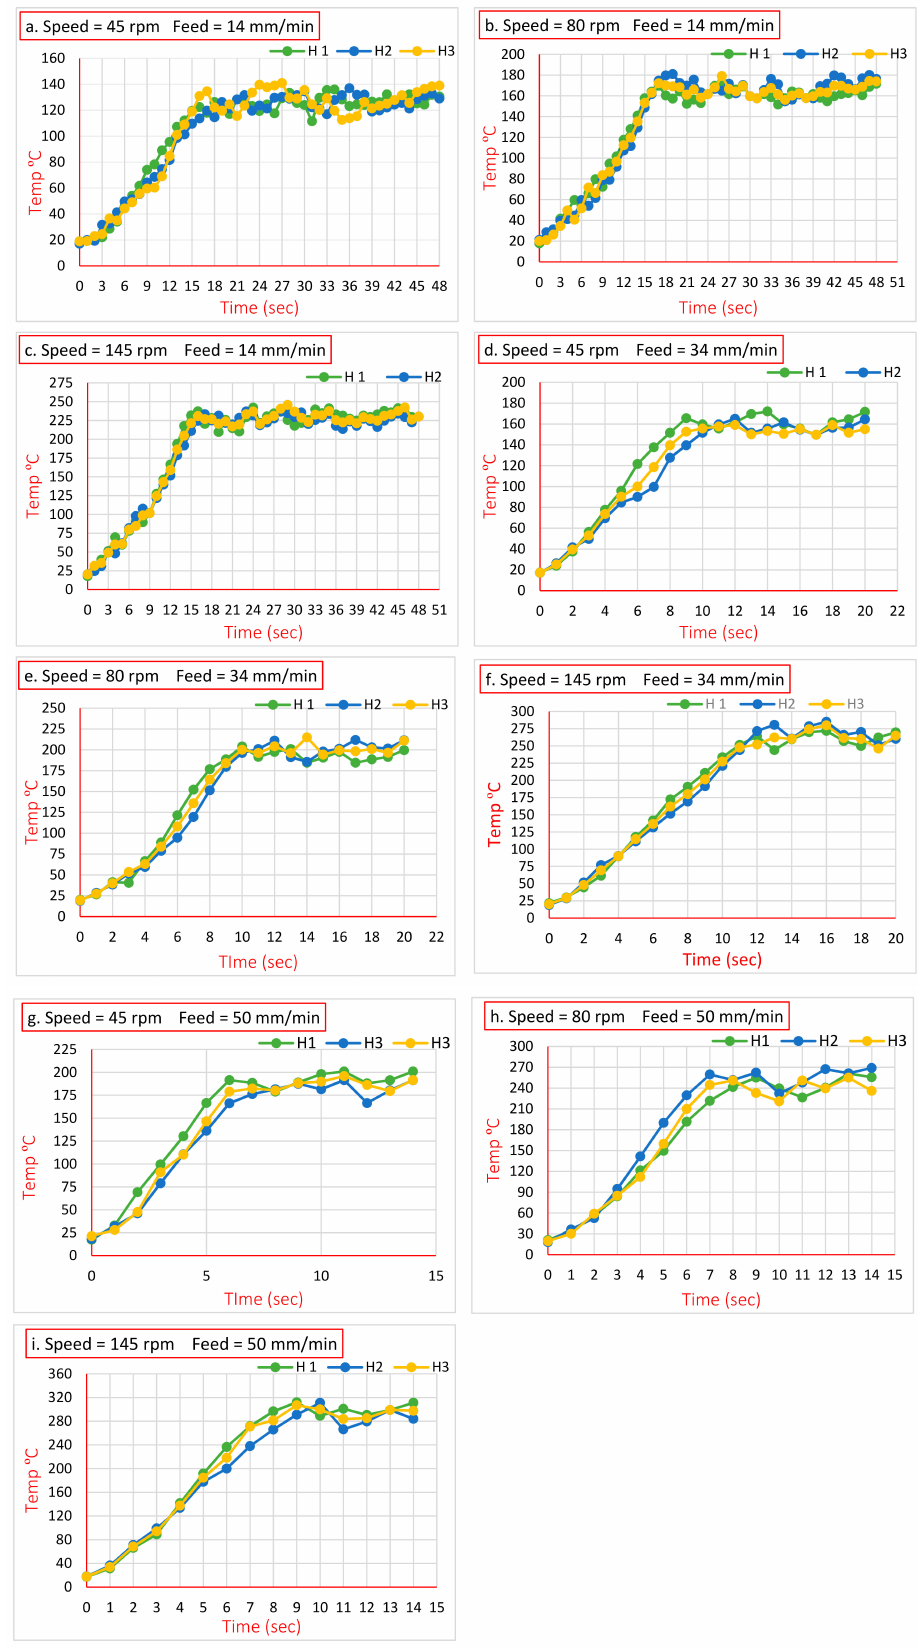
Figure 9. Temperature changing profiles during drilling for each set of cutting conditions ( a – i